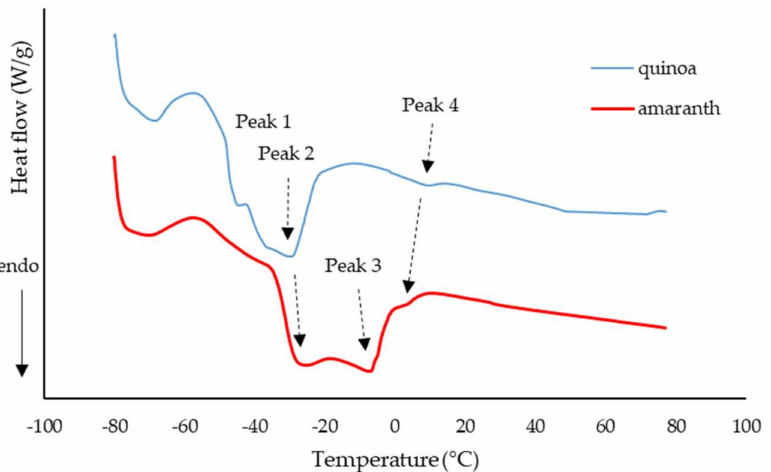
Figure 3. Melting DSC curves, determined in the temperature range − 80–80 ◦ C of amaranth (red line) and quinoa (blue line) oils.